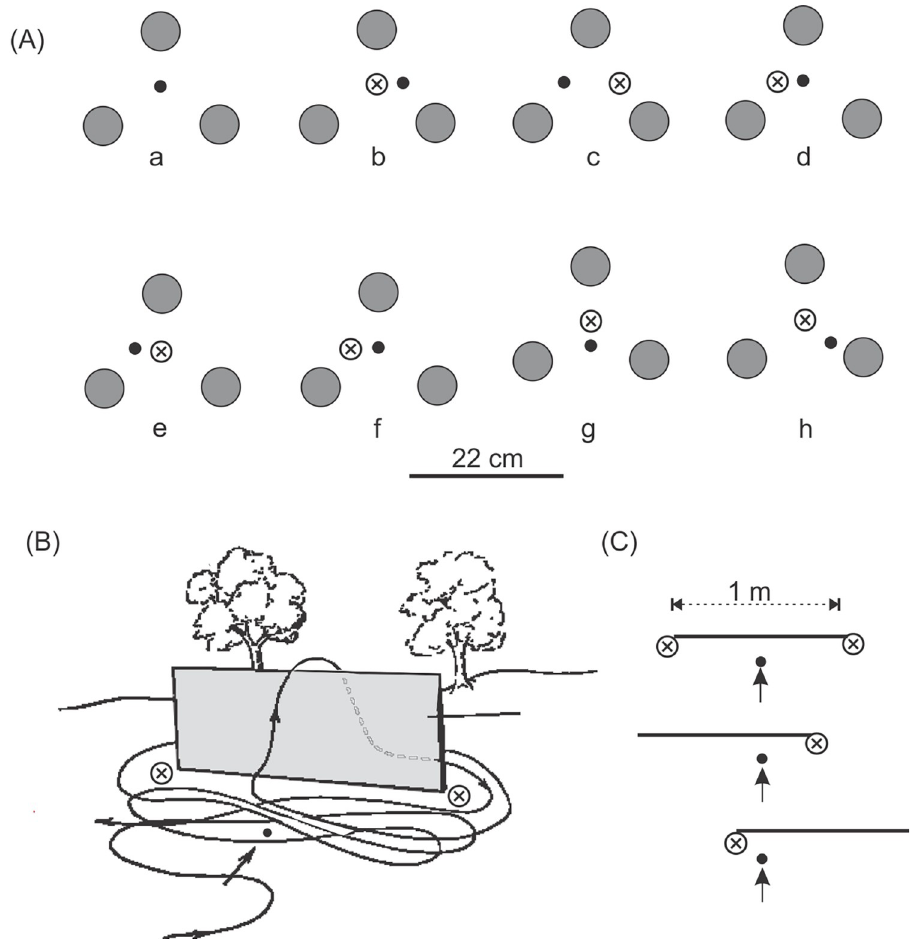
Fig 4. The influence of local and distant cues. (A) A typical example of how one of 5 wasps responded to shifts of local landmarks. Three cork stoppers (gray circles) were introduced around the burrow entrance (black dots) of a wasp. (a) training trial for the wasp to learn introduced cork-configuration cue surrounding the burrow prior to first shift. (b)–(h) consecutive configuration-shifts and digging attempts ( � ) of this particular wasp, which eventually does find her burrow; each initial digging following a subsequent shift was where the wasp was last successful, relative to the configuration. At (g) the wasp was not permitted to find her burrow before the next shift, resulting in her digging relative to configuration in (h) at a location where she had found the burrow in (f). (B) A wasp responding to the presence of an opaque barrier behind the burrow, with digging attempts at either end of the barrier with unimpeded view of the wider surrounding. (C) Same wasp digging at the ends of the barrier when the latter is centered on the burrow, then digging at either end, when the barrier is shifted to the left and right of the burrow.